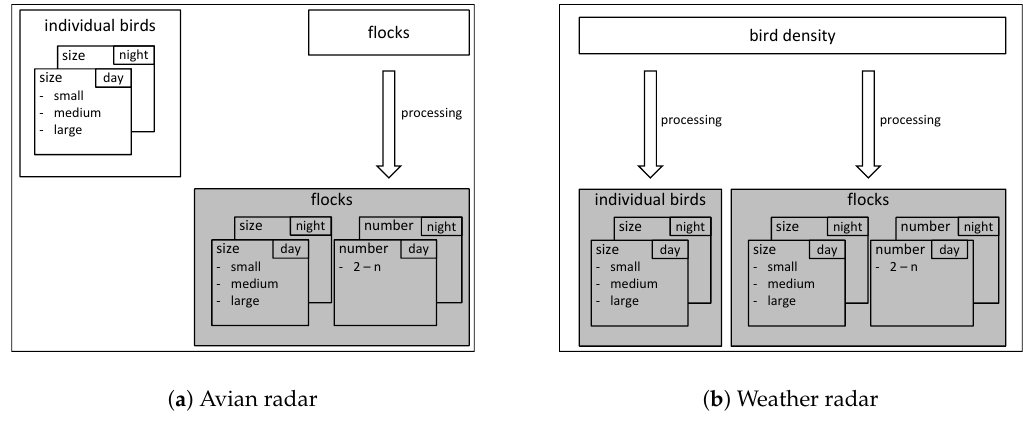
Figure 1. Steps for retrieving flock size distributions (white: input information. grey: processed information). Avian radar ( a ): Input contains distribution between individual birds and flocks. For individual birds, size information for day and night is contained. Numbers of birds per flock as well as body size distribution within flocks were modelled. Weather radar ( b ): Input contains bird density. Distribution between birds flying individually and in flocks were modelled for day and night as well as are represented bird sizes and number of birds within flocks. Table 2. Determined flock size groups within the range of the avian radar (0–200 m) during daytime.